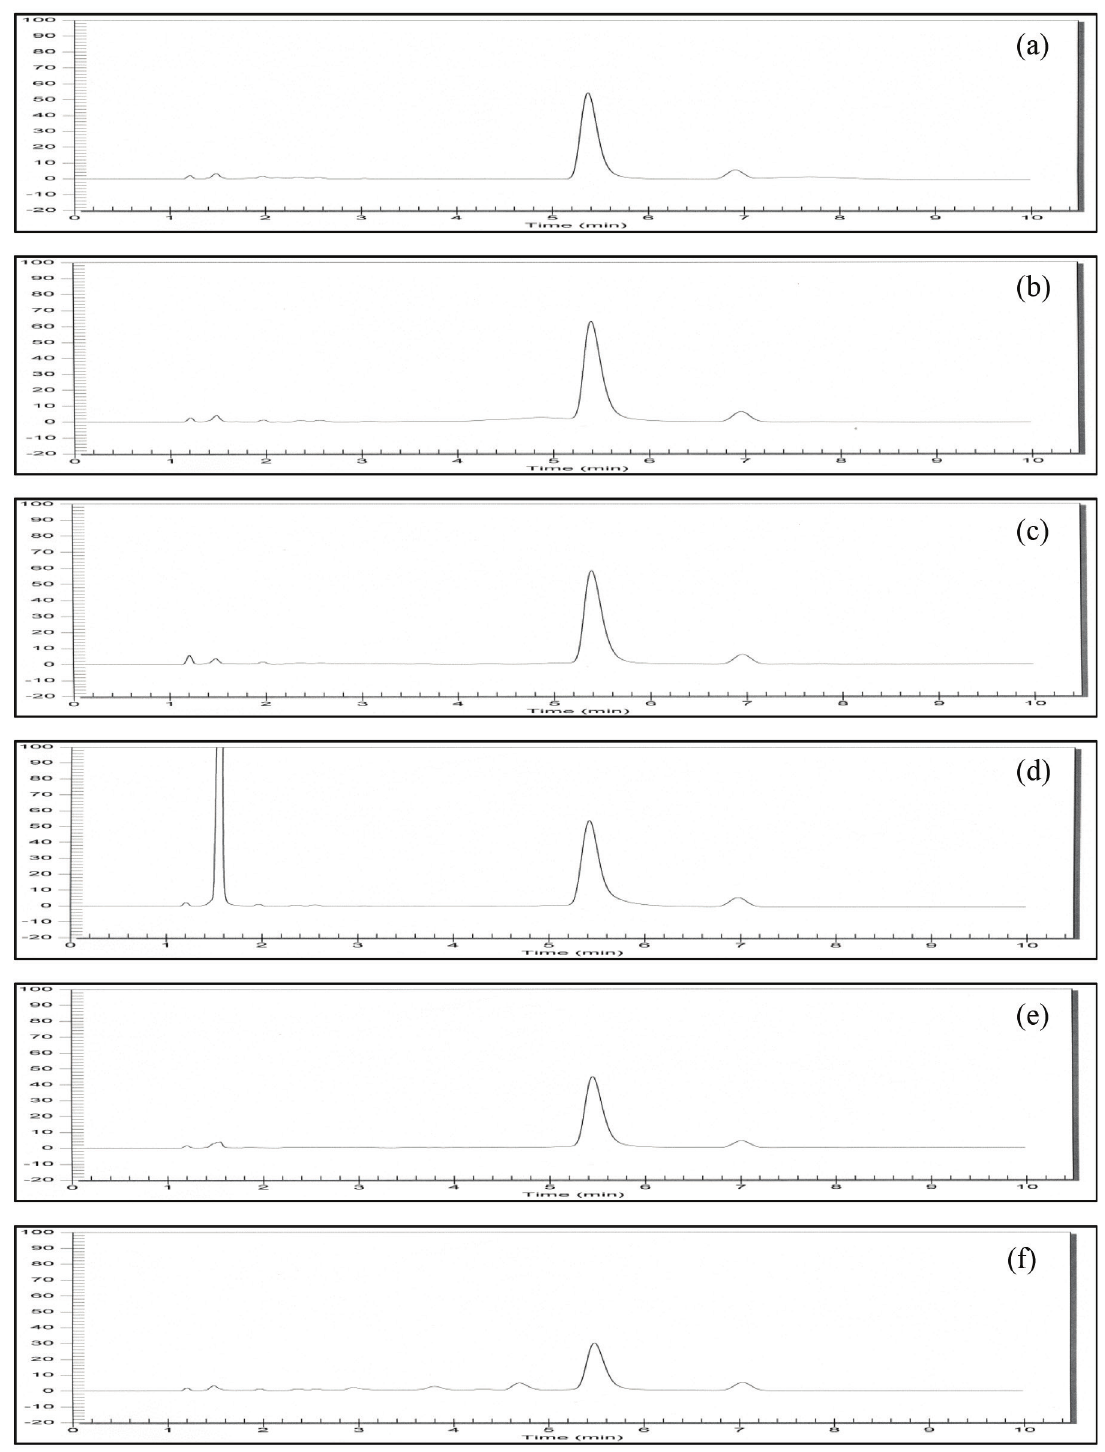
FIGURE 3 - IPLC chromatograms of stressed conditions; (a) ketoconazole shampoo, (b) acid hydrolysis, (c) base hydrolysis, (d) oxidation, (e) thermal and (f)